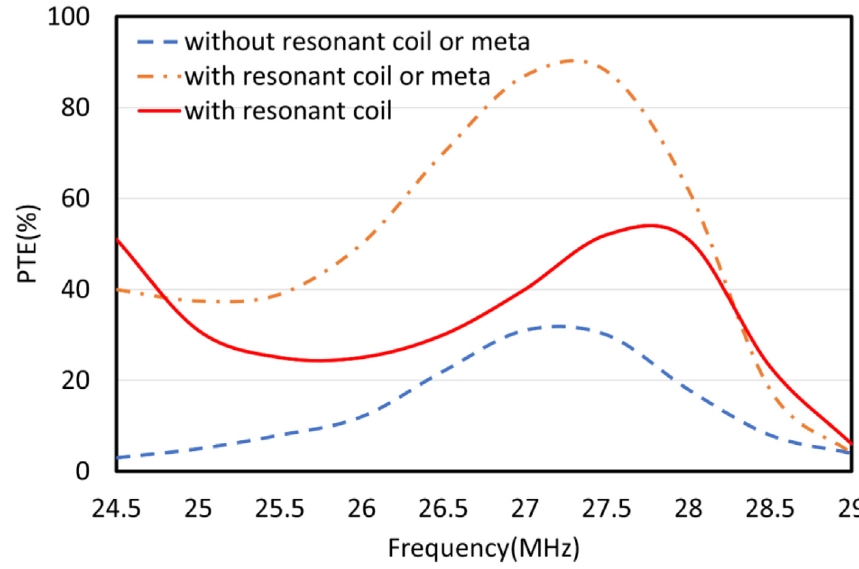
Fig. 3. Ef fi ciency comparison of three WPT systems.